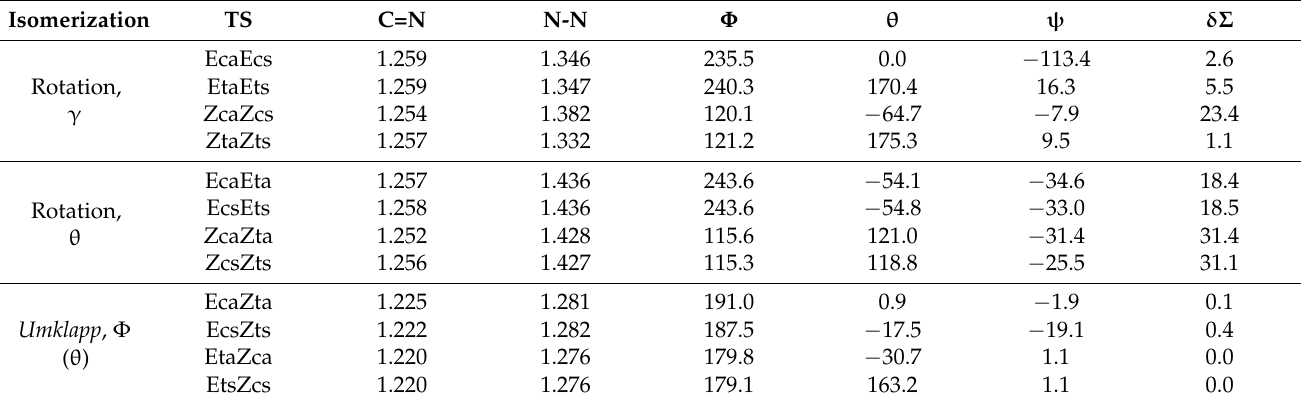
Table 9. Selected molecular geometric parameters of the TS structures of 1 calculated at the ω B97M- D4/cc-pVTZ level. Bond lengths are in angstroms, planar and dihedral angles are in degrees.